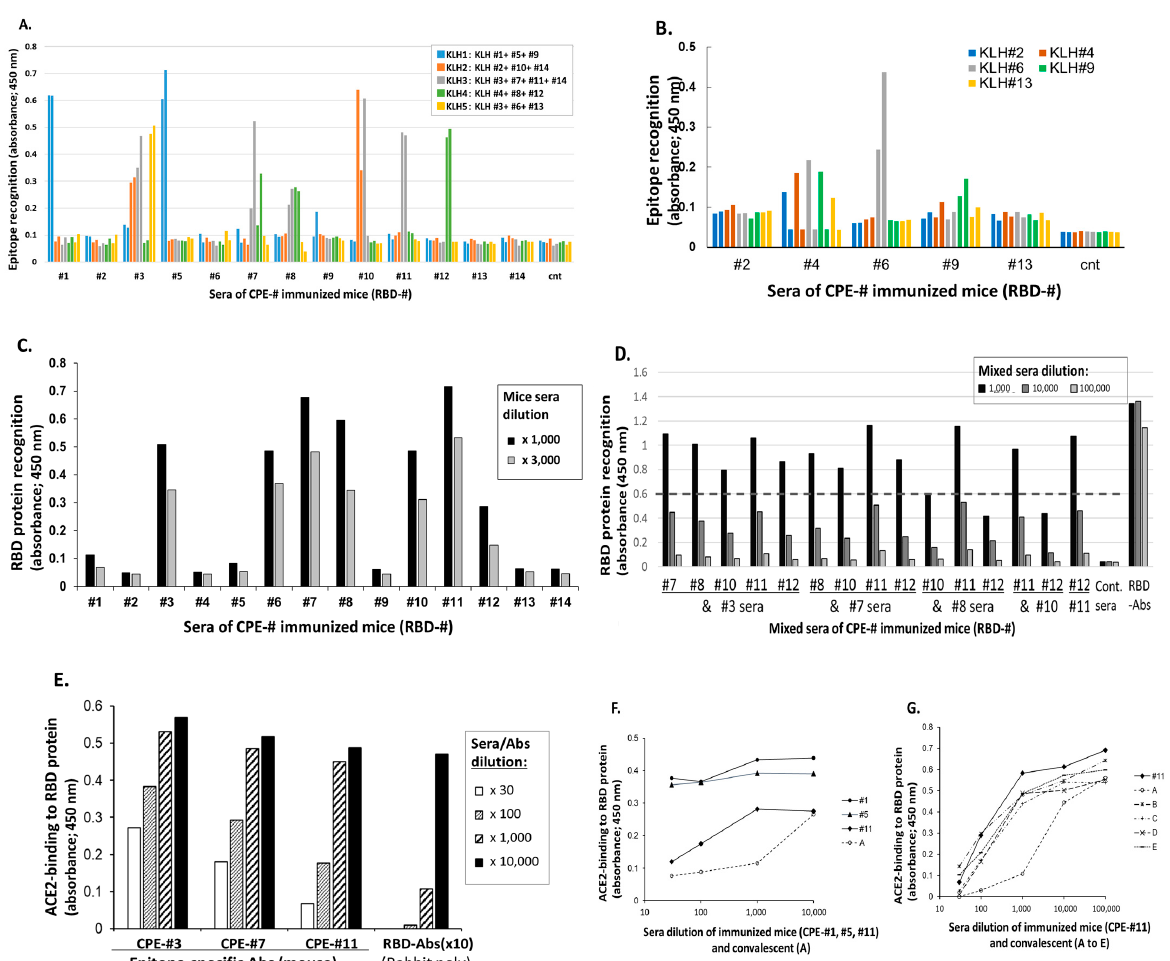
Figure 1. Selection of epitopes in S1-RBD in which specific antisera are functional. ( A ) Induction of CPE-specific IgG Abs in mice immunized with individual CPE-Ags covering RBD amino acid sequences (experiment 1). The sera of two mice immunized with individual CPE-Ag were evaluated for recognition of CPEs presented on irrelevant carrier protein KLH. The sera dilution was x1000-fold, and positive signals were defined as s/n>5 compared to the signals of sera of non-immunized mice. The OD values showed means of duplicate assays in diluted sera of each two mice. ( B ) Confirmation of CPE-specific IgG Abs induction in two other mice immunized with individual S1-RBD CPE-Ags (experiment 2). Epitopes #2, #4, #6, #9 and #13-specific Abs were performed again for confirming the experiment 1. ( C ) Assessment of RBD protein recognition in all CPE-specific antisera. Individual CPE-specific IgG Abs were examined for recognition of recombinant S1-RBD protein. The serial dilutions of mice sera in each CPE group were assessed for binding to S1-RBD recombinant protein. ( D ) Additive recognition by combinations of each single epitope-specific antisera. The individual #3, #7, #8, #10, #11 or #12 epitope-specific antisera was combined with each other and assessed if equal mixtures of them enhanced signals of RBD recognition. ( E ) Identification of RBD-epitopes recognizing antisera able to inhibit binding of ACE2. The #3, #7 and #11 CPE-specific antisera inhibited binding of RBD and hACE2 proteins, and commercially available anti-RBD polyclonal Abs (purified) inhibited this binding effectively. The OD values shown as bar graph are means of triplicate assays. ( F , G ) Comparison of inhibitory activities against RBD-hACE2 binding in RBD-recognizing epitope-specific antisera, RBD-unrecognizing epitope-specific antisera and moderate/severe COVID- 19 patients’ sera were evaluated by RBD-hACE2 binding assays. As control mice sera, the epitope #1 and #5-specific antisera unable to recognize RBD protein were also set up in parallel, and these two sera did not inhibit the binding of RBD to hACE2